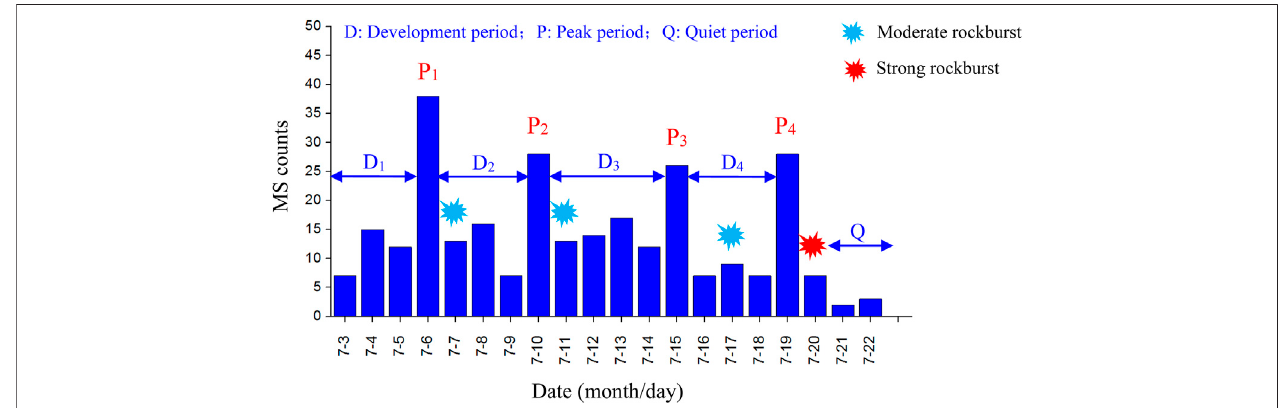
FIGURE 12 | The histogram of relationship between microseismic events and time in diversion tunnel #3.